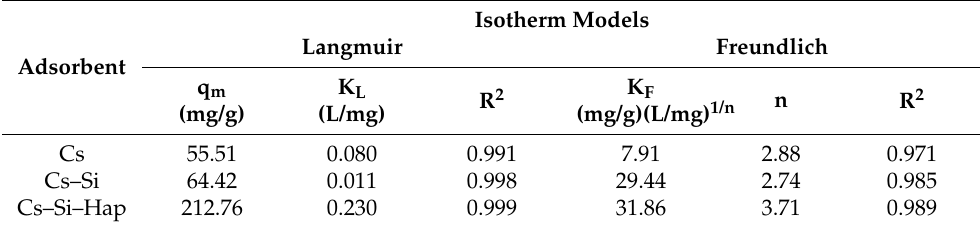
Table 2. Isotherms models parameters for Cr(VI)